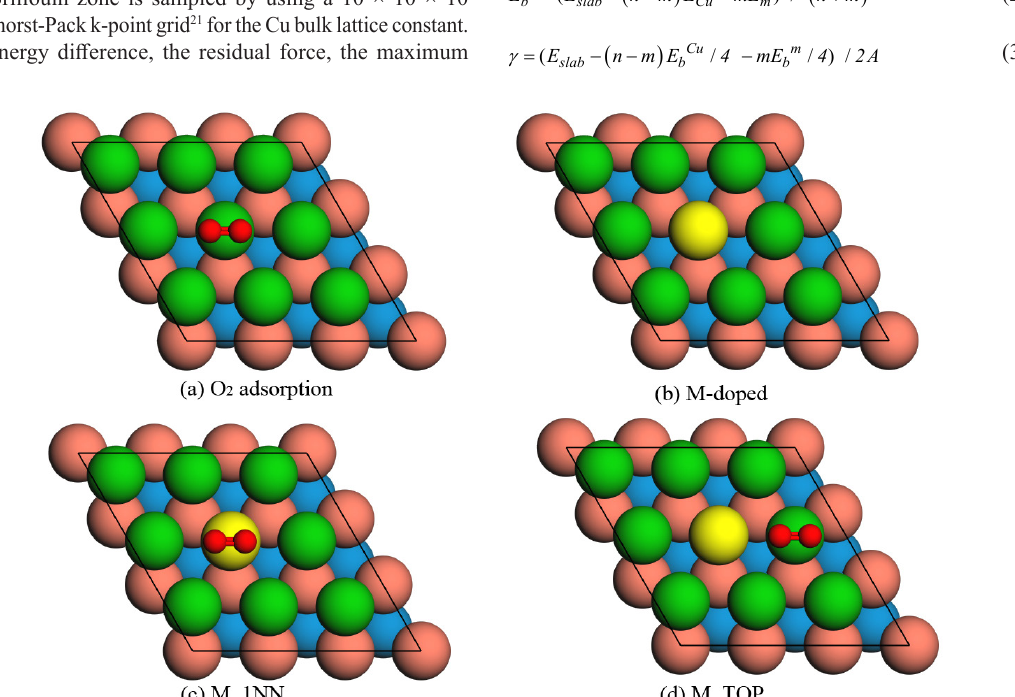
adsorption pristine/doped Cu (111) surface. (a) is the O adsorption pristine surface. (b) is the M-doped Figure 1. The initial structures of O 2 2 surface. (c) is O adsorption on TOP-type doped surface. (d) is the O adsorption on 1NN-type doped surface. The green, bronzing and blue 2 2 particles denote the first, second, third layers of Cu atoms. The oxygen and doping atoms are shown in red and yellow color,